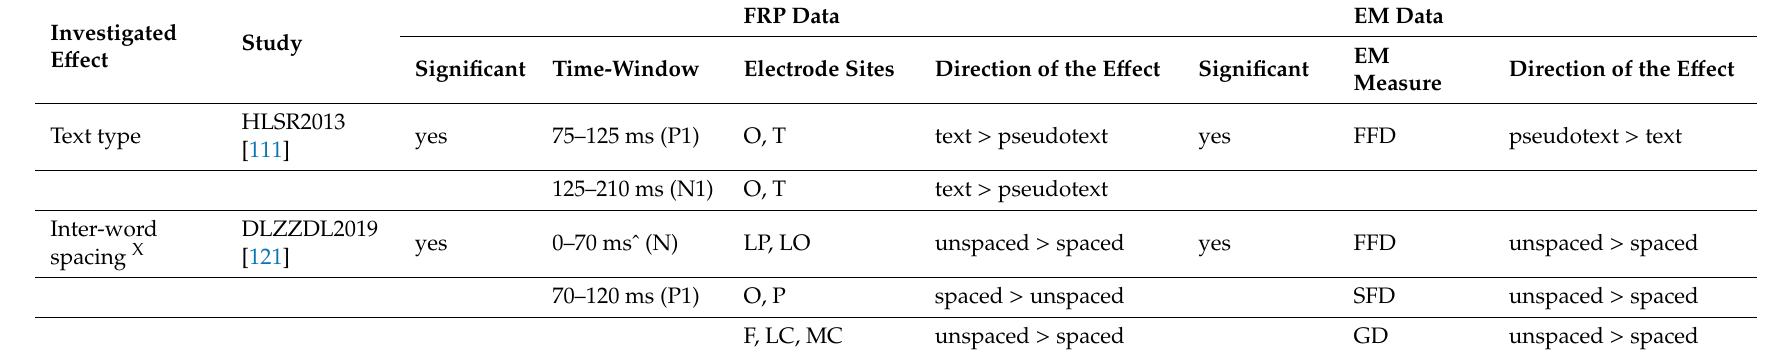
Table 4. Summary of the Findings Reported in Co-Registration Studies Investigating Foveal Processing from Fixation Onset on the Target Word. In these studies, both EMs and FRPs were time-locked to the initial fixation onset on the target word, to examine variables that a ff ect processing of a word from (at least) its initial fixation onward and their time